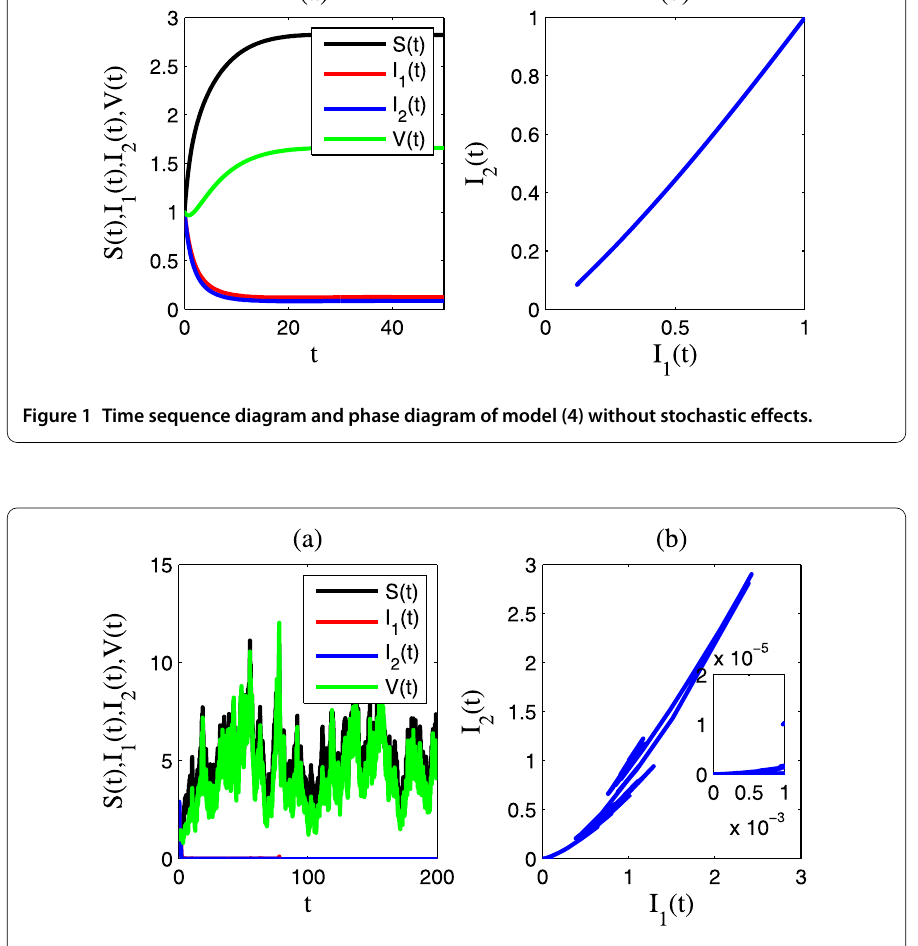
Figure 2 Time sequence diagram and phase diagram of model (4) for extinction of two epidemic